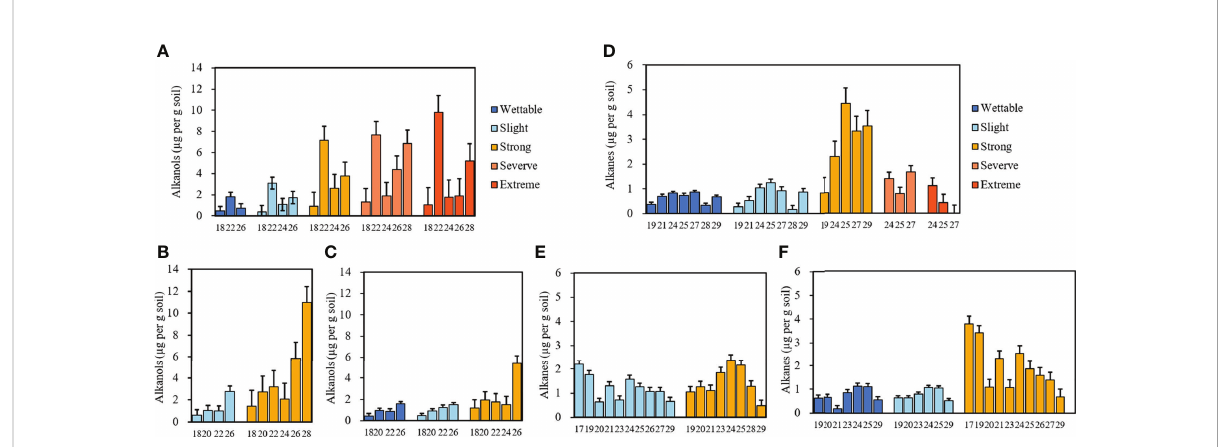
FIGURE 5 Relative concentrations of alkanols and alkanes with different carbon numbers beneath Pinus (A , D) , Robinia (B , E) , and Hippophae (C, F)